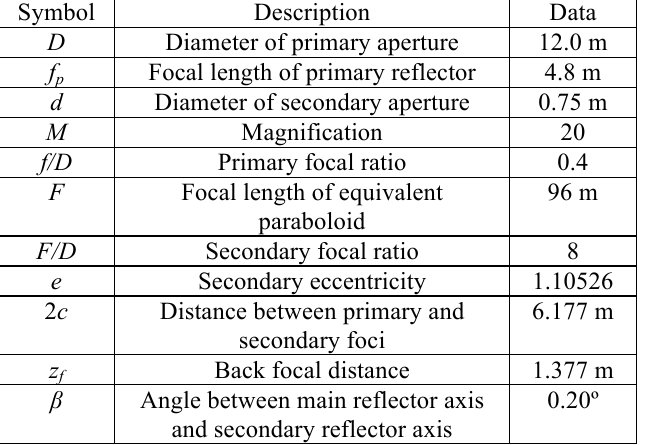
Table 1: Parameters for the offset Cassegrain antenna.